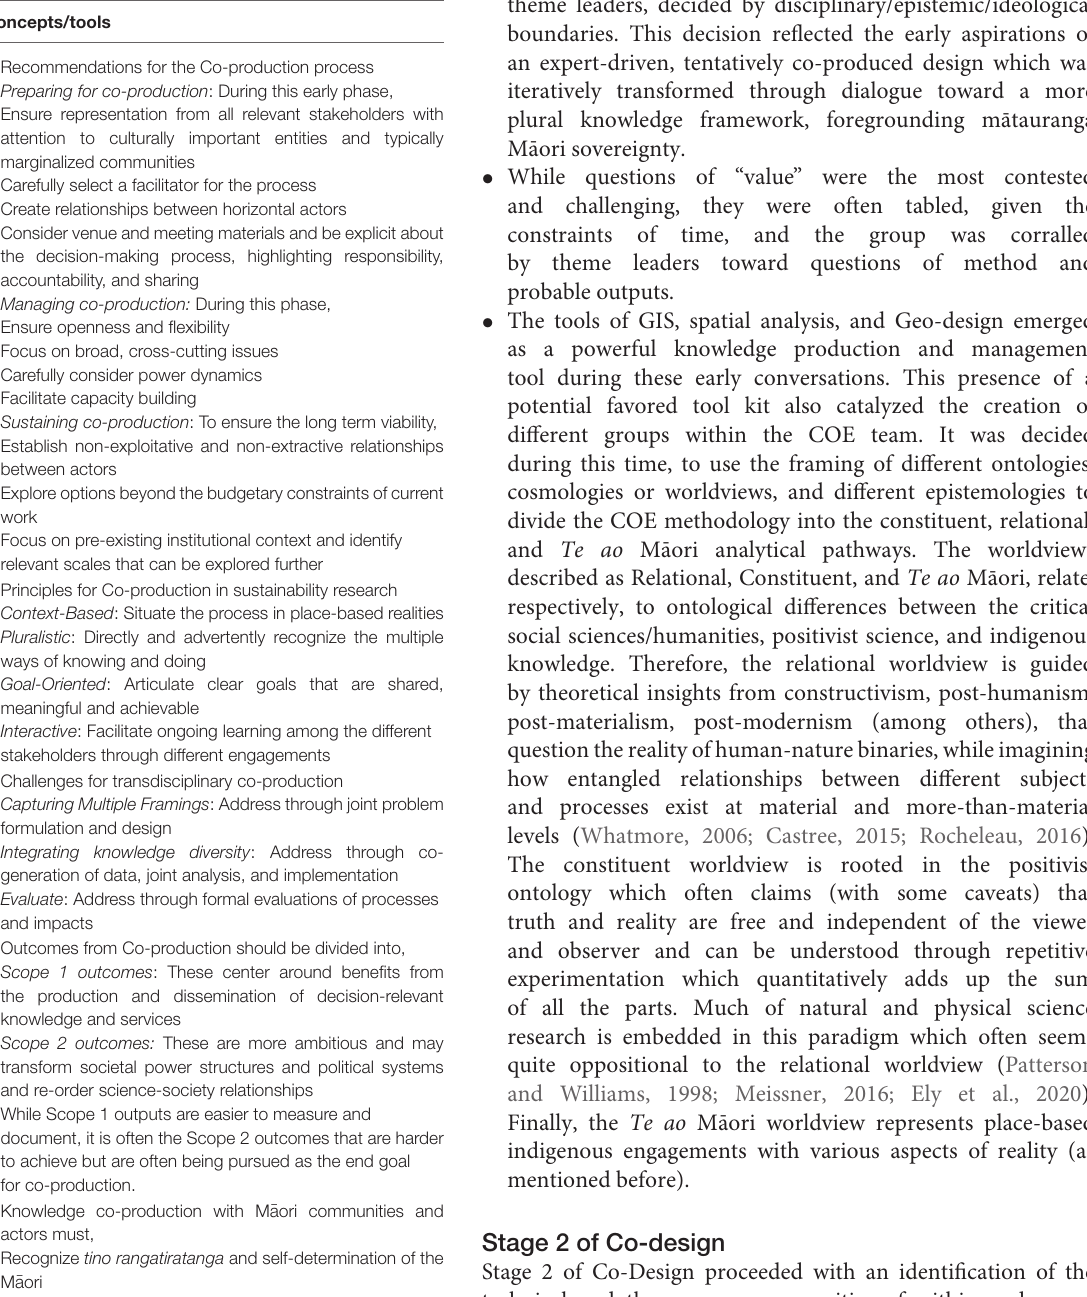
TABLE 3 | Identifying guiding principles and goals for knowledge